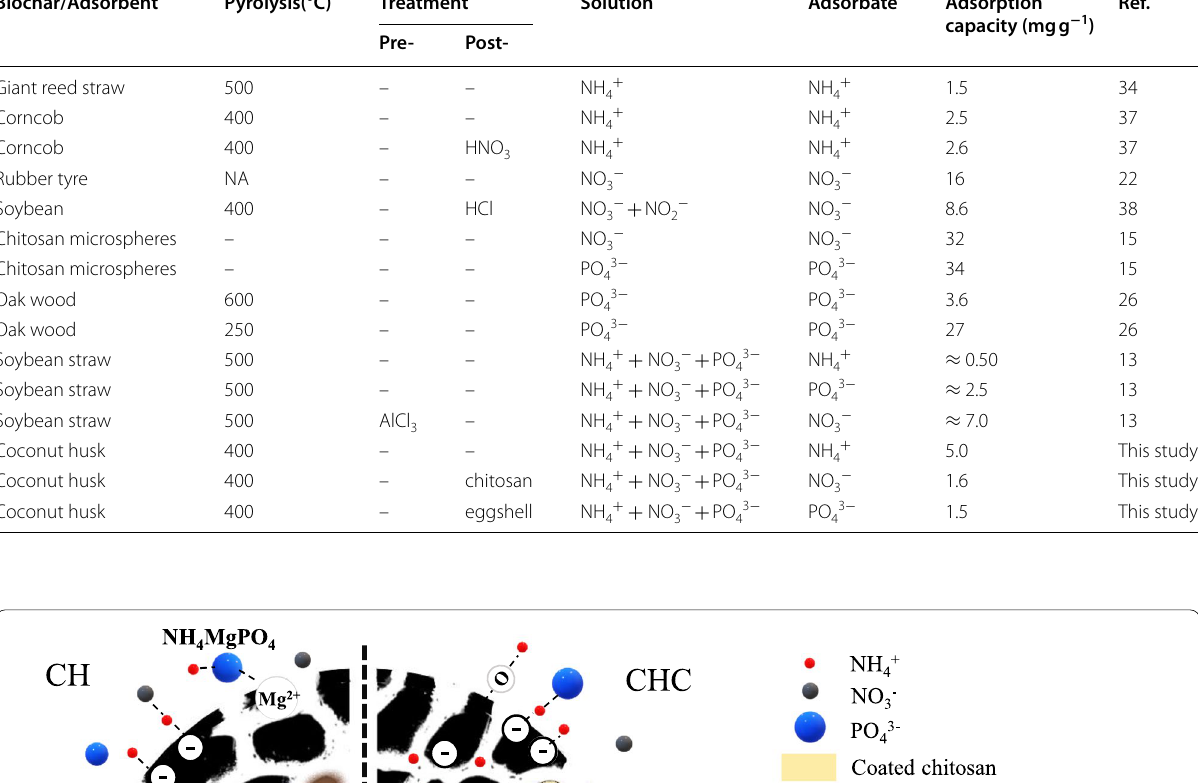
Table 5 Comparison of the nutrient adsorption capacity of different adsorbents Biochar/Adsorbent